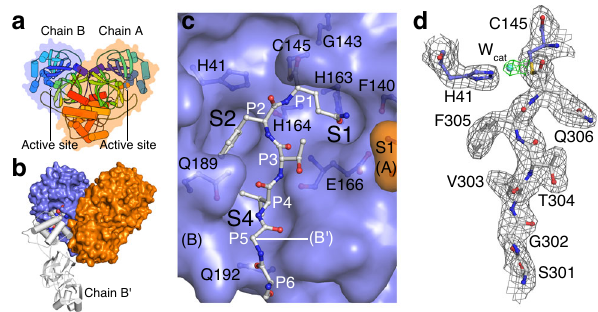
Fig. 1 Wild-type SARS-CoV-2 M pro acyl-enzyme intermediate structure